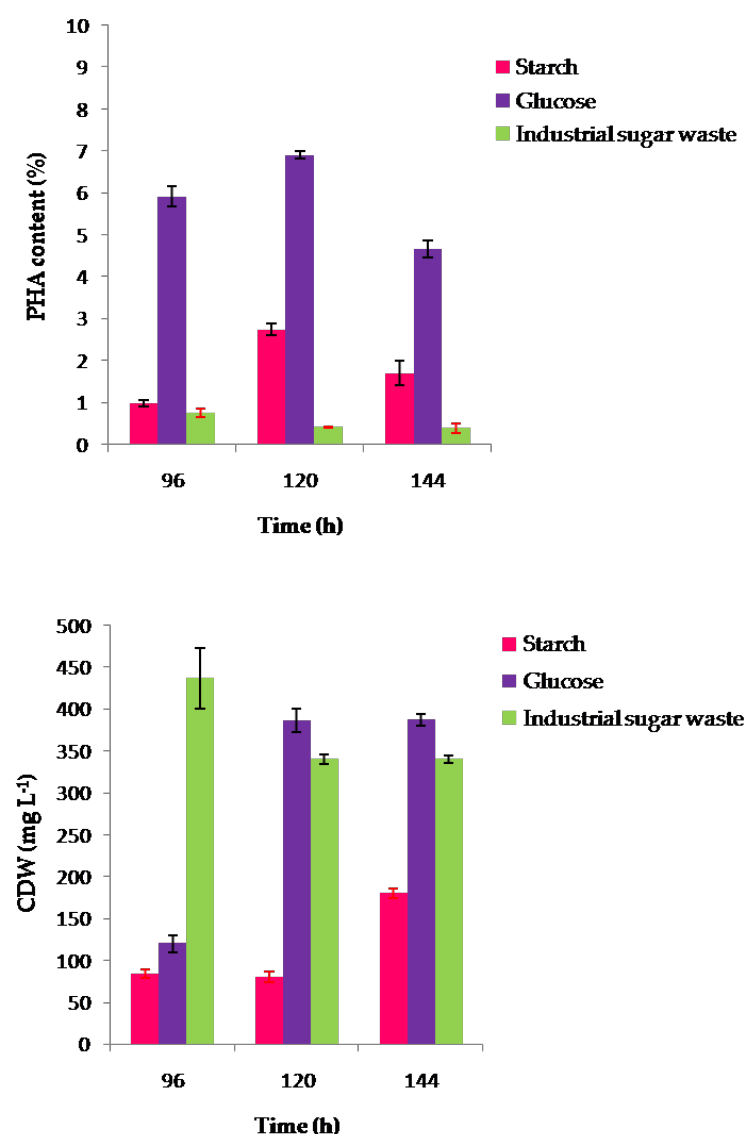
Figure 4. E ff ect of di ff erent carbon sources on CDW (mg L − 1 ) and PHA content (wt %) of the